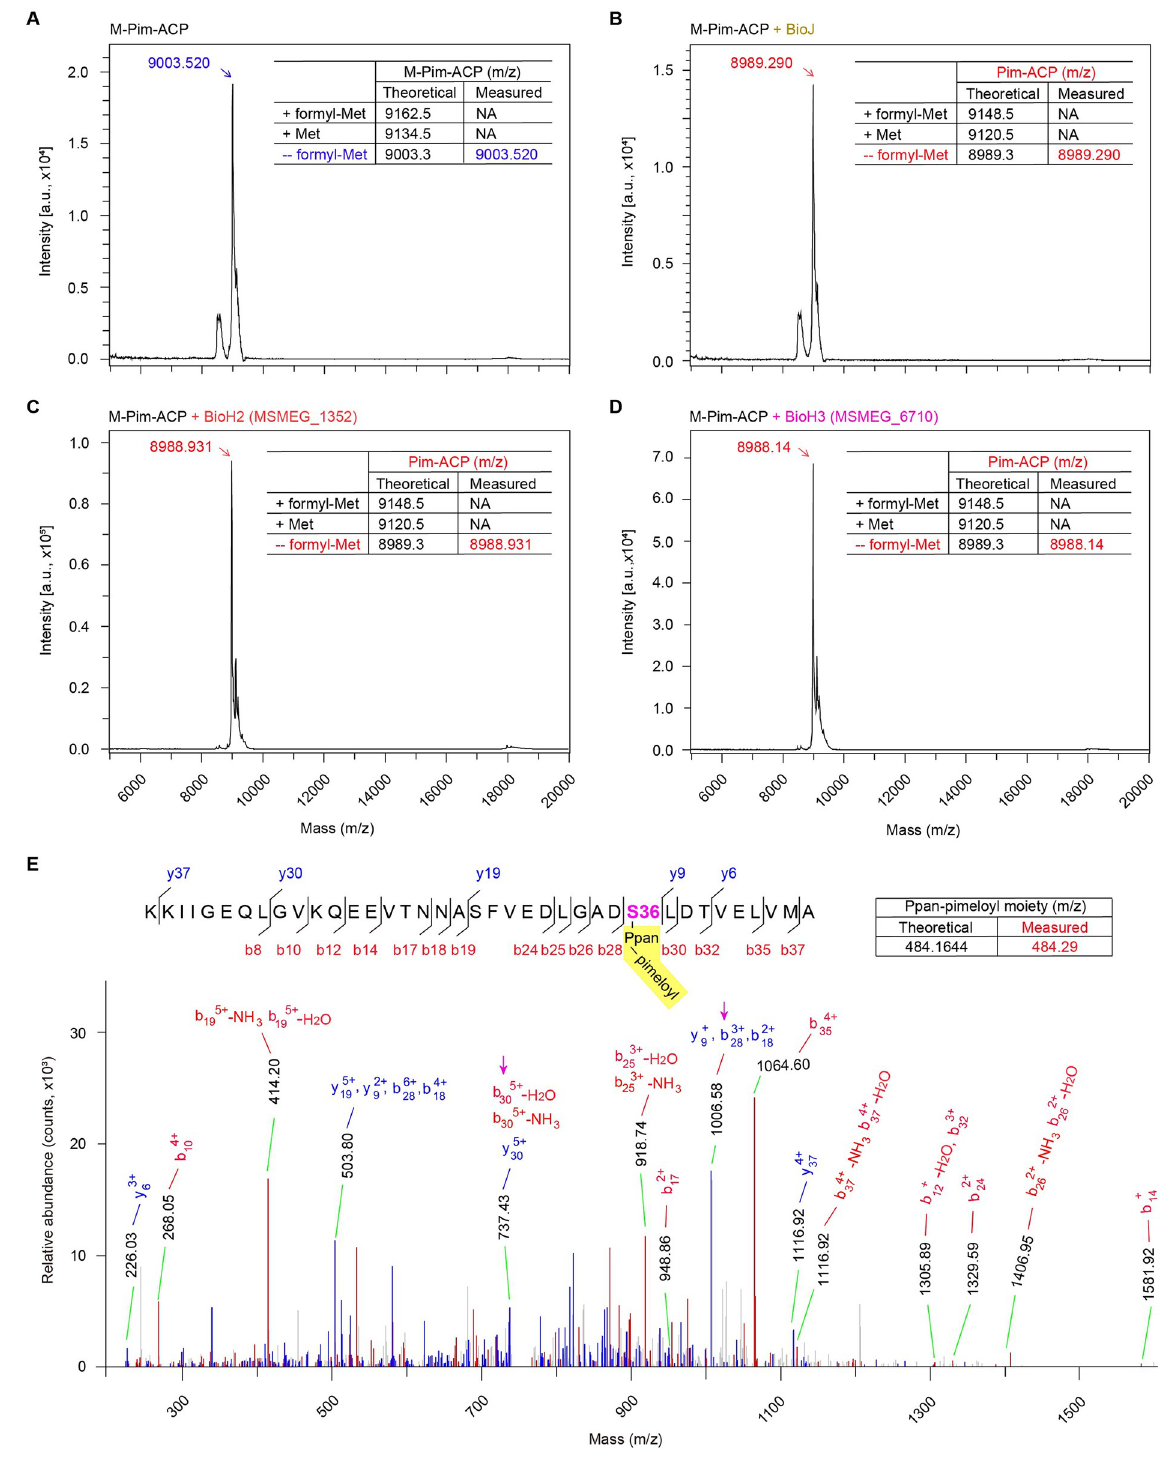
Fig 5. MS evidence for the enzymatic cleavage of the physiological substrate of pimeloyl ACP methyl ester by BioH2 and BioH3. A. MALDI-TOF profile for the substrate of pimeloyl-ACP methyl ester. B. MALDI-TOF identification of the pimeloyl-ACP product arising from BioJ hydrolysis of pimeloyl-ACP methyl ester. MALDI-TOF evidence that BioH2 ( C ) and BioH3 ( D ) both demethylate the reactant pimeloyl- ACP methyl thioester to give pimeloyl-ACP product. E. Use of high-resolution mass spectrometry to detect a pool of ACP peptide fragments of which the serine 36 (S36) features with a single pimeloyl modification. Designations: ACP, Acyl carrier protein; Pim-ACP, pimeloyl-ACP; M- pim-ACP, Methyl-pimeloyl-ACP; BioJ, Fransicella pimeloyl-ACP methyl ester carboxyl-esterase; NA, not available; Ppan, Phosphopantetheine.